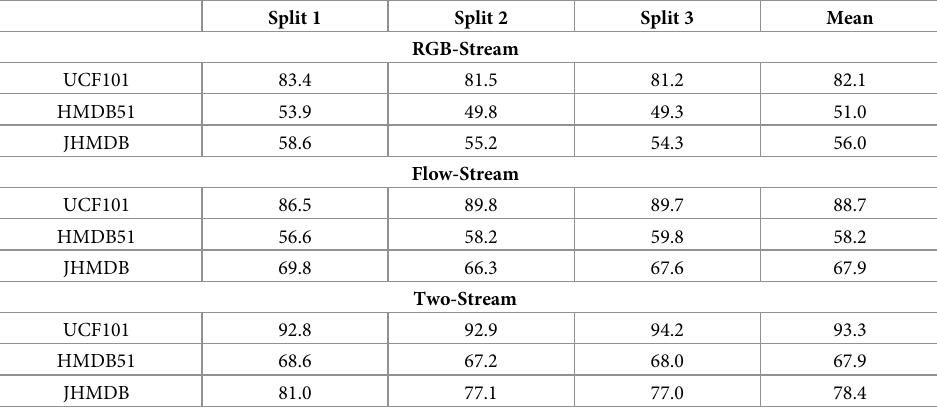
Table 3. Performances of our STA-TSN on UCF101 (all three splits), HMDB51 (all three splits), and JHMDB (all three